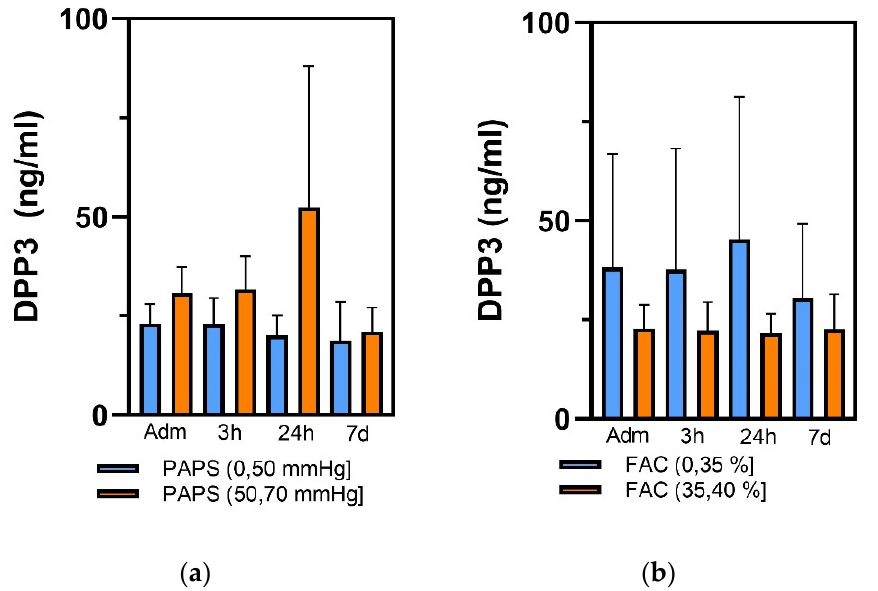
Figure 3. Graphs illustrating the distribution of cDPP3 levels in ( a ) patients with PAPS lower and higher than 50 mmHg and ( b ) patients with FAC lower and higher than 35% at time points at ICU